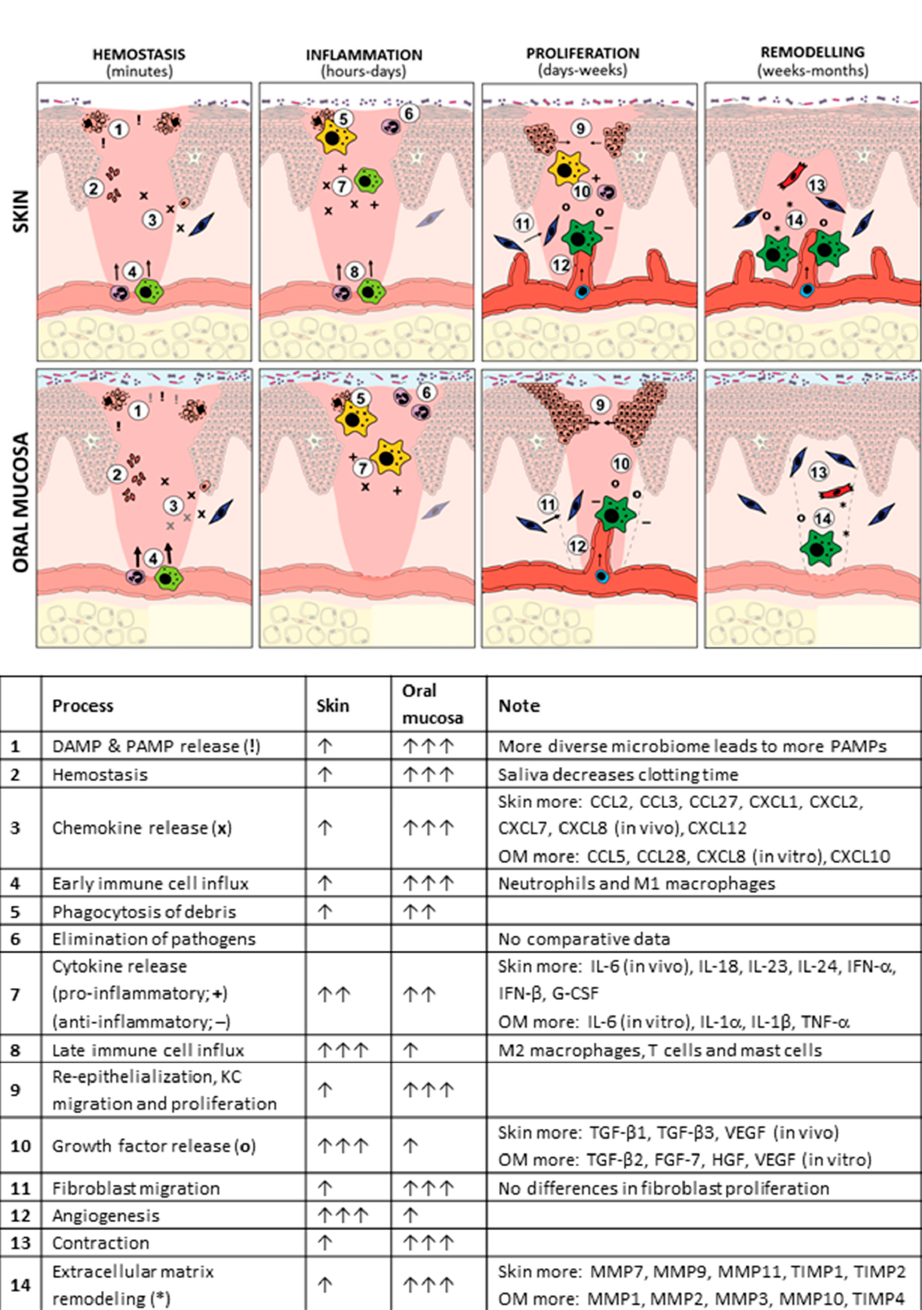
Figure 5. Overview of differences between oral and skin during wound healing. For more extensive information on all cells and molecules involved in skin versus oral wound healing and corresponding references, see Supplementary Tables S1–S3. DAMP (!), damage-associated molecular pattern; PAMP (!), pathogen-associated molecular pattern; OM, oral mucosa; IL, interleukin; KC, keratinocyte; TGF (o), transforming growth factor; VEGF (o), vascular endothelial growth factor; FGF (o), fibroblast growth factor; HGF (o), hepatocyte growth factor; MMP (*), matrix metalloproteinase; TIMP (*), tissue inhibitor of MMP.